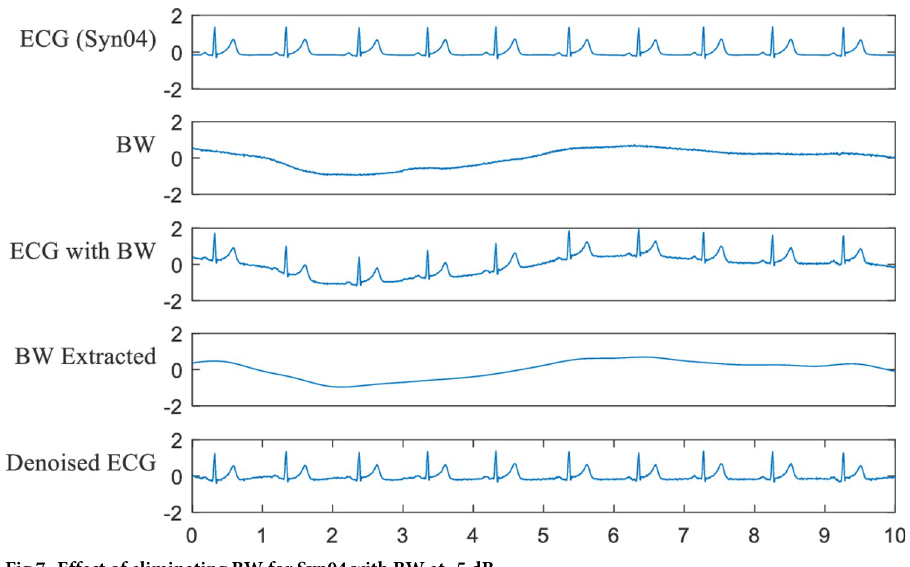
Fig 7. Effect of eliminating BW for Syn04 with BW at -5 dB.